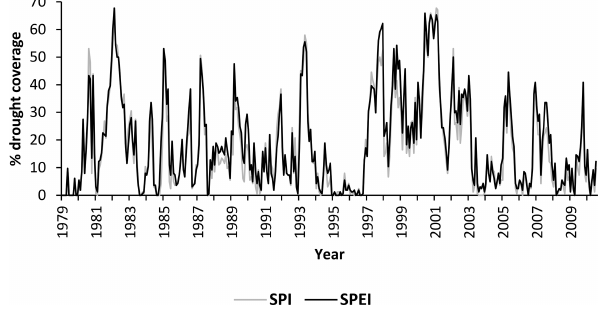
Figure 1. New Zealand percent area covered by SPI and SPEI val- ues ≤ − 1.